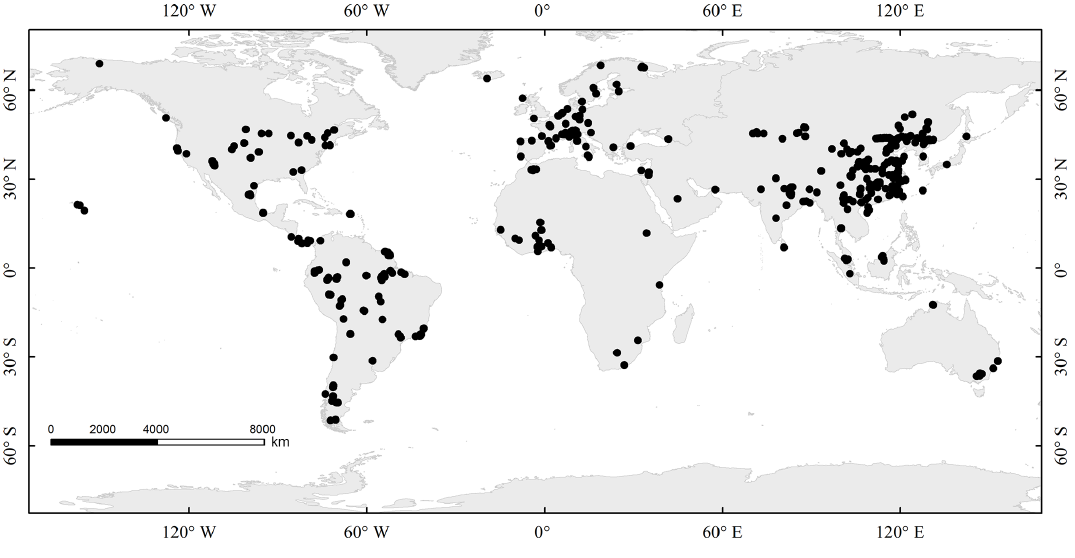
Figure 1. Geographic distribution of sample sites used in this synthesis. Table 1. Plant carbon content (%) in four organs across different life forms. n is the sample size, and SD is the abbreviation of standard deviation. Samples for stem include the samples from shoot, stem, twig, and branch. “–” indicates no data. Reproductive organ Root Leaf Stem Life form n Mean ±